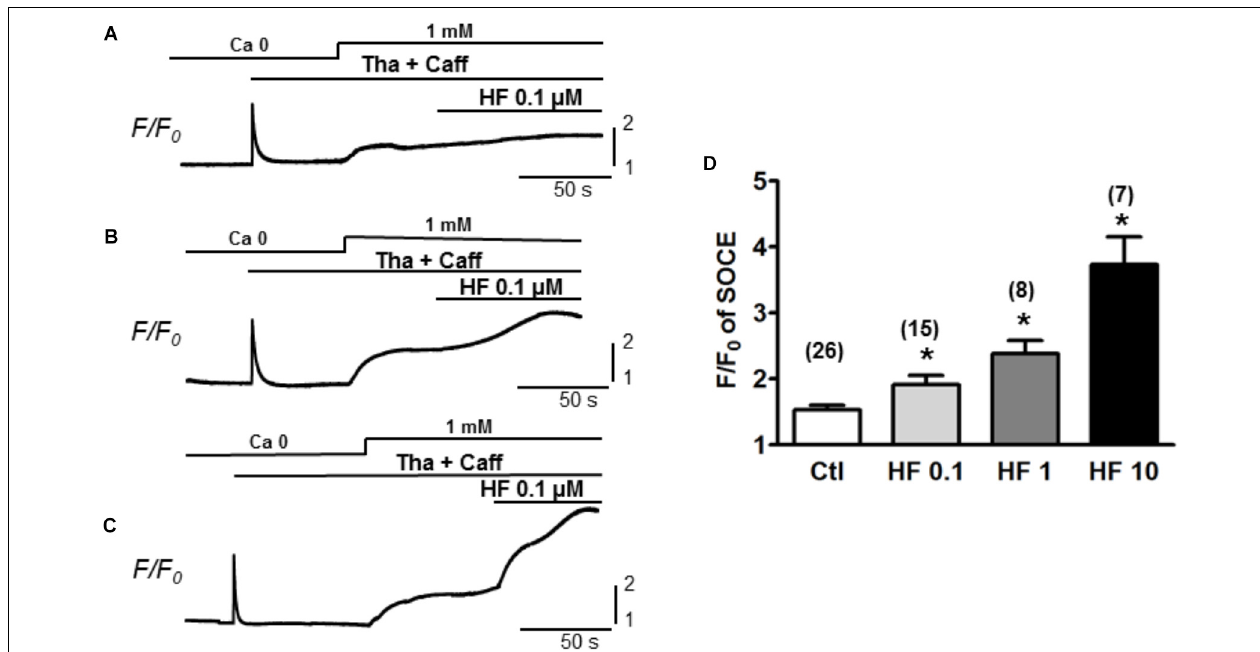
FIGURE 3 | TRPC6 activator hyperforin potentiates the SOCE in adult mouse cardiac myocytes. (A–C) Representative recordings of SOCE from adult mouse myocytes. Ca 2 + fluorescence intensity (F/F 0 ) in normal Tyrode’s solution (1 mM Ca 2 + ) and Ca 2 + -free (0 Ca) Tyrode’s solution was measured. SOCE was detected under complete depletion by 0.1 µ M thapsigargin and 1 mM caffeine (Tha + Caff), and was further enhanced by hyperforin (HF) at different concentrations. (D) Summary of F/F 0 responses (SOCE) in the presence of 0.1, 1, and 10 µ M hyperforin, which potentiated SOCE in a concentration-dependent fashion. ( ∗ p < 0.05 compared to control, Student’s t